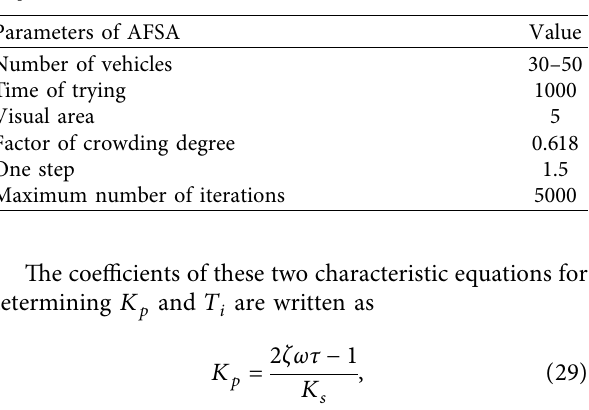
Table 2: the parameters set for AFSA in tuning the PI controller [23].